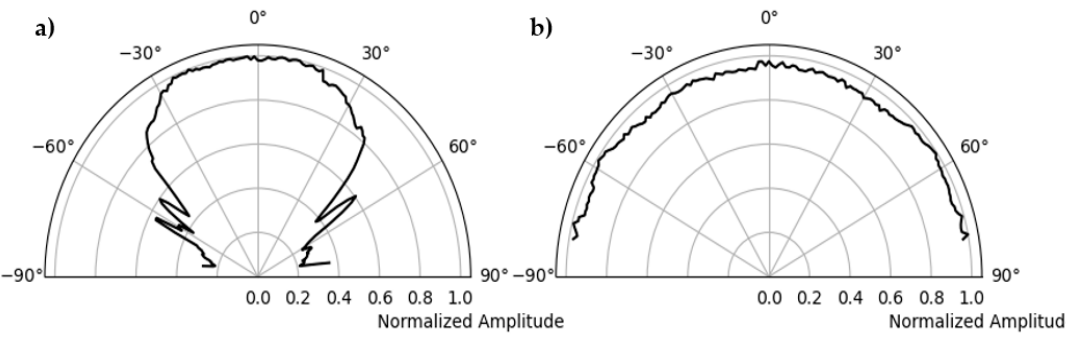
Figure 14. Directivity measurement of point source, ( a ) radiation pattern of single shear wave probe polarization along test plane, ( b ) polarization perpendicular to test plane.